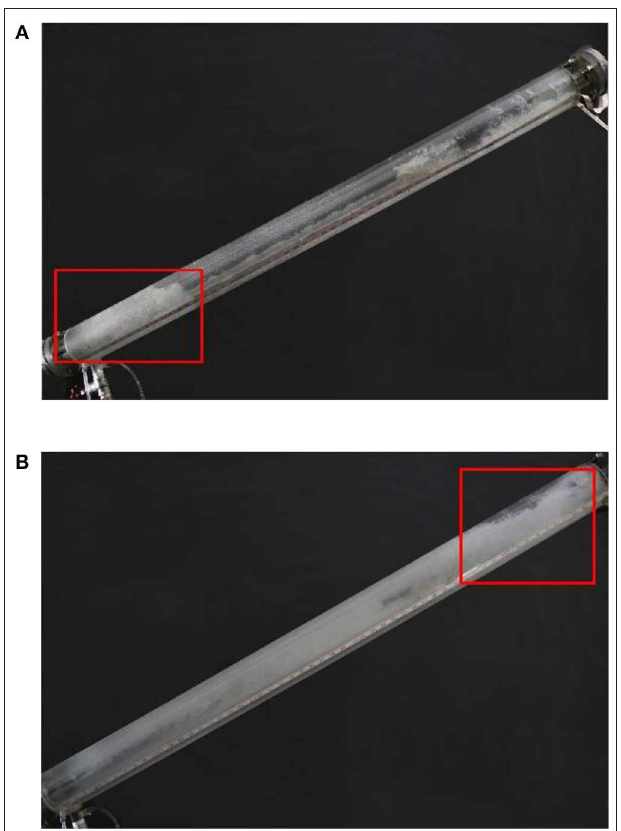
FIGURE 6 | The performance of separator under unreasonable liquid levels. (A) Low liquid level. (B) High liquid